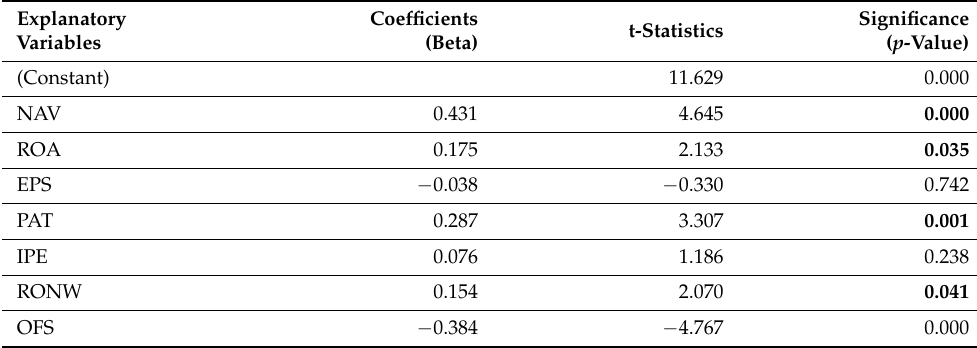
Table 7. Results of Model 2 for Offer Price Regression.